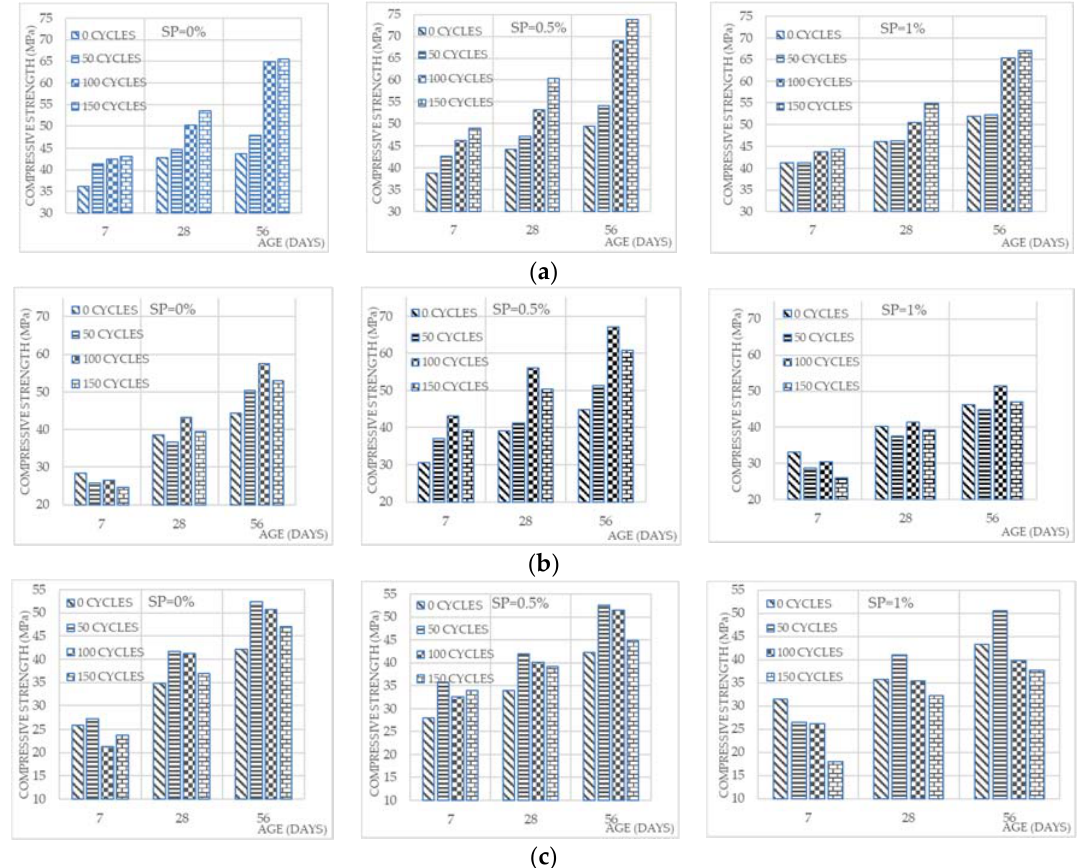
Figure 7. Effect of magnetic water (MW) on the compressive strength of mortar. ( a ) FA = 0.00% ( b ) FA = 10.00% ( c ) FA = 20.00%.